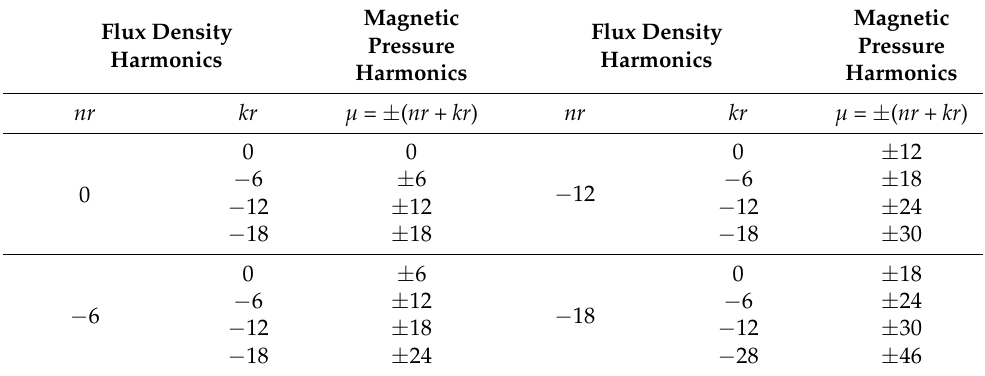
Table 6. Relationship between the harmonics of the flux density and the harmonics of the magnetic pressure created by the armature of the Qs48p8 machine on the rotor surface.